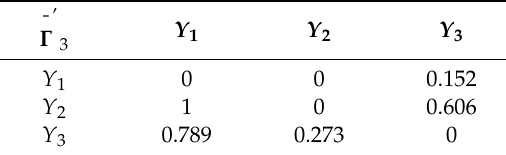
Table 29. The normalized rejoice matrix Γ